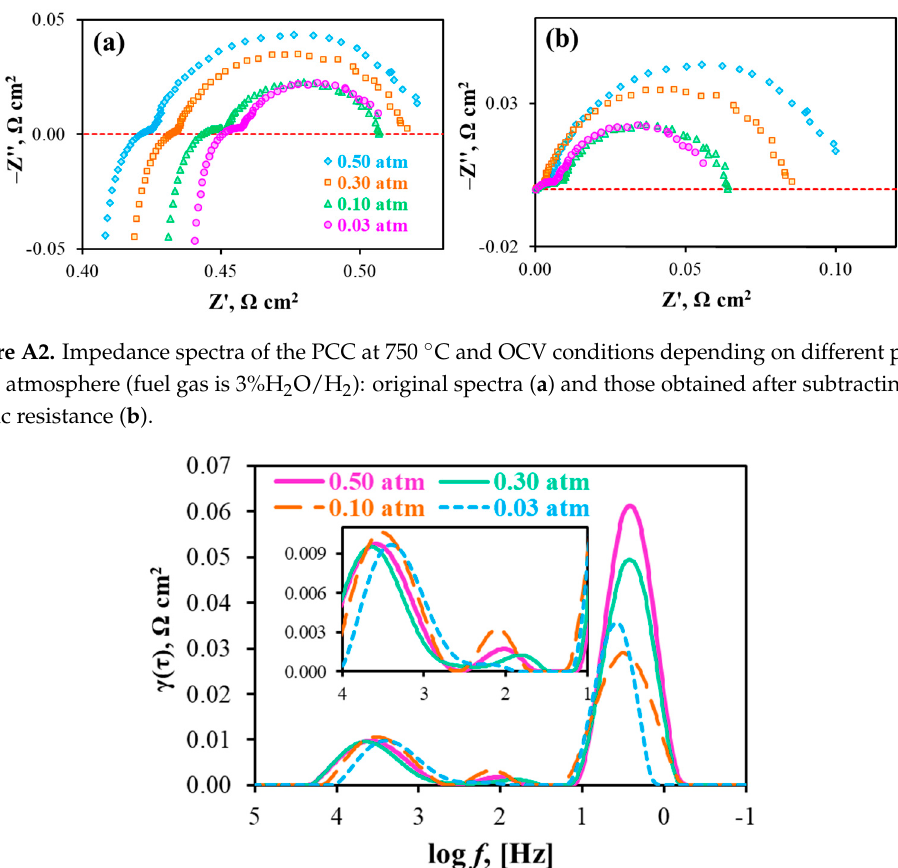
Figure A1. Temperature dependences of constitute resistances (R j ) of the fabricated PCC in Arrhenius coordinates. The corresponding activation energies calculated in Frenkel coordinates (log(T/R j ) = ƒ(1/T)) are also presented.